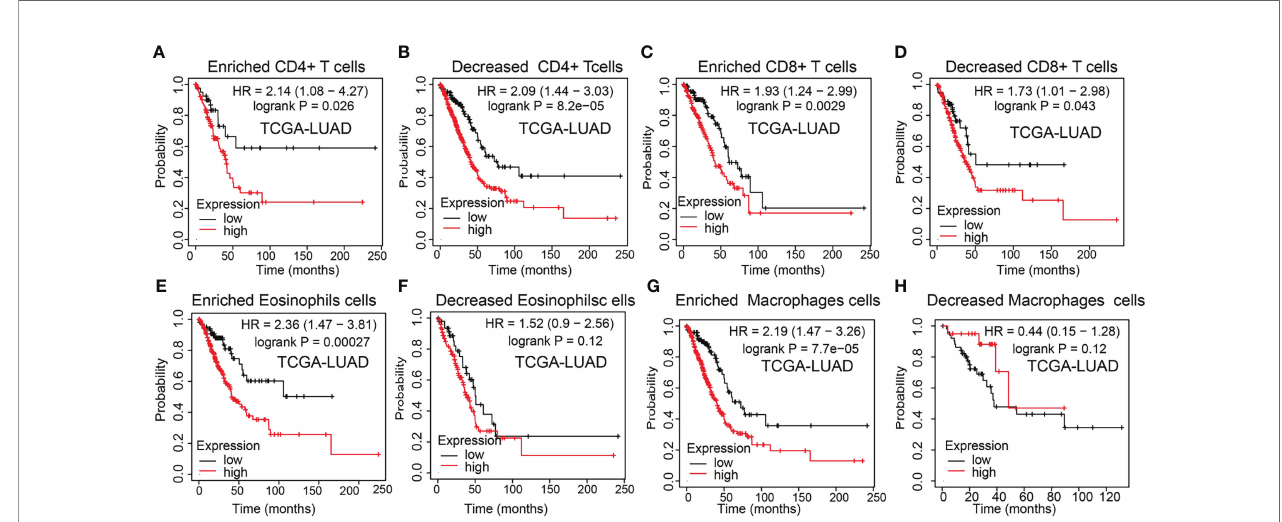
FIGURE 10 | Kaplan – Meier survival curves according to the high and low expression of NCAPG2 in immune cell subgroups in LUAD. (A – H) Correlations between NCAPG2 expression and overall survival in different immune cell subgroups in LUAD patients were determined by Kaplan – Meier plotter.